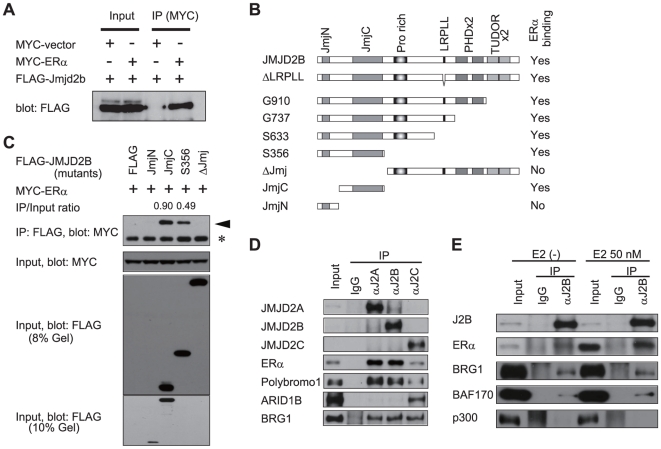
JMJD2B interacts with ERα and SWI/SNF-B complex.(A) JMJD2B co-immunoprecipitates with ERα. 293T cells were co-transfected with expression plasmids for FLAG-JMJD2B and either MYC-ERα or empty vector. Cell lysate and α-MYC immunoprecipitates were analyzed by western blot with α-FLAG antibody. (B) Structure of JMJD2B deletion mutants. Pro rich, proline rich region. LRPLL, LRPLL motif. PHDx2, double PHD domain. TUDORx2, double TUDOR domain. Western blot analysis of mutants is shown in Figure S3A. (C) The JmjC domain is sufficient for co-immunoprecipitation with ERα. 293T cells were co-transfected with MYC-ERα and individual JMJD2B deletion mutant expression vectors (refer to B). Cell lysates and α-FLAG immunoprecipitates were analyzed by western blot with antibodies to the indicated proteins. Relative intensity of the bands of the mutants is shown, normalized to the bands of corresponding input. Arrowheads, ERα bands; *, α-FLAG antibody. (D) Association of JMJD2 proteins with ERα, SWI/SNF complex, or SWI/SNF-B complex. (E) Association of JMJD2B with ERα or SWI/SNF-B complex in the absence or presence of estrogen simulation. (D and E) Nuclear lysates of T-47D cells were immunoprecipitated with control IgG or antibodies to the indicated proteins. Input lysate and immunoprecipitated samples were immunoblotted using antibodies to the indicated proteins. See also Figure S3. Full-length blots are in Figure S7.